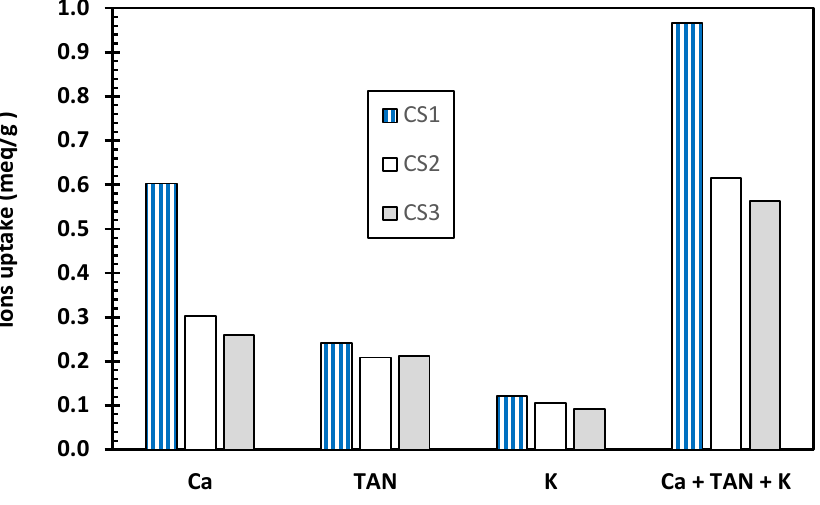
Figure 3. Ion uptakes at the of the CS loading phases.